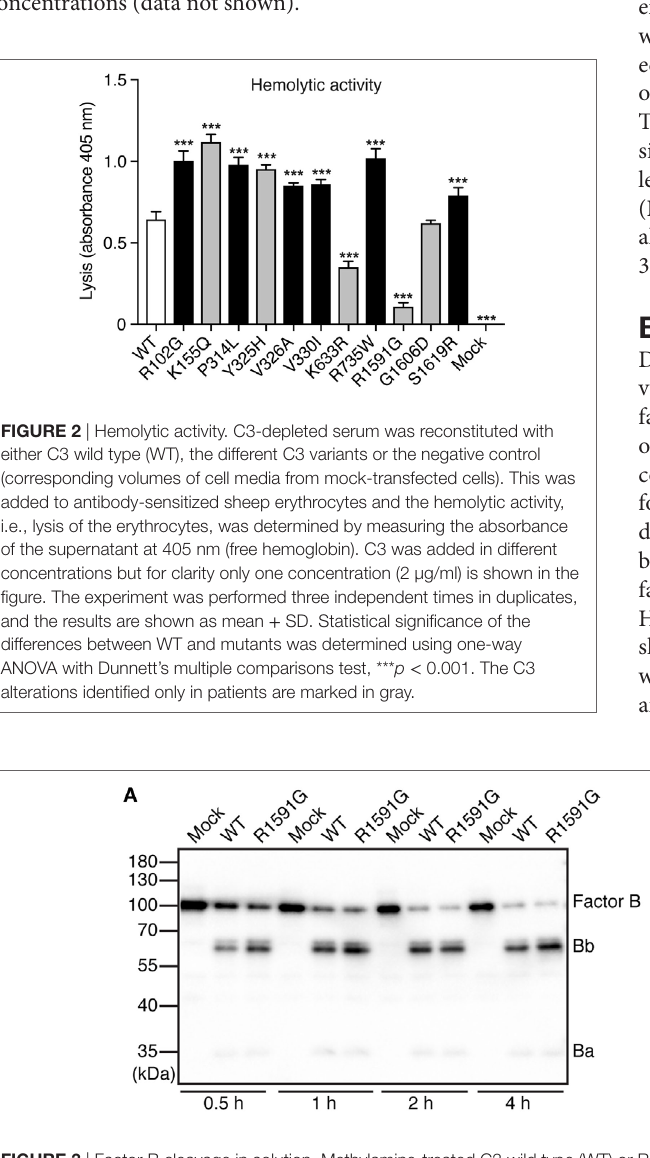
FigUre 3 | Factor B cleavage in solution. Methylamine-treated C3 wild type (WT) or R1591G (or mock medium as negative control) was incubated with factor B and factor D for indicated time points, before being subjected to Western Blotting and factor B detection. A representative blot is shown in panel (a) . The bands corresponding to intact factor B as well as the Bb degradation product were quantified by densitometry. Data in panel (B) show the ratio between the intensity of these two bands. Each sample was analyzed in a single replicate, and the data are shown as mean + SD from four independent experiments. Two-way ANOVA with Dunnett’s multiple comparisons test was used to calculate statistical significance of the difference between WT and R1591G, ** p < 0.01 and *** p <